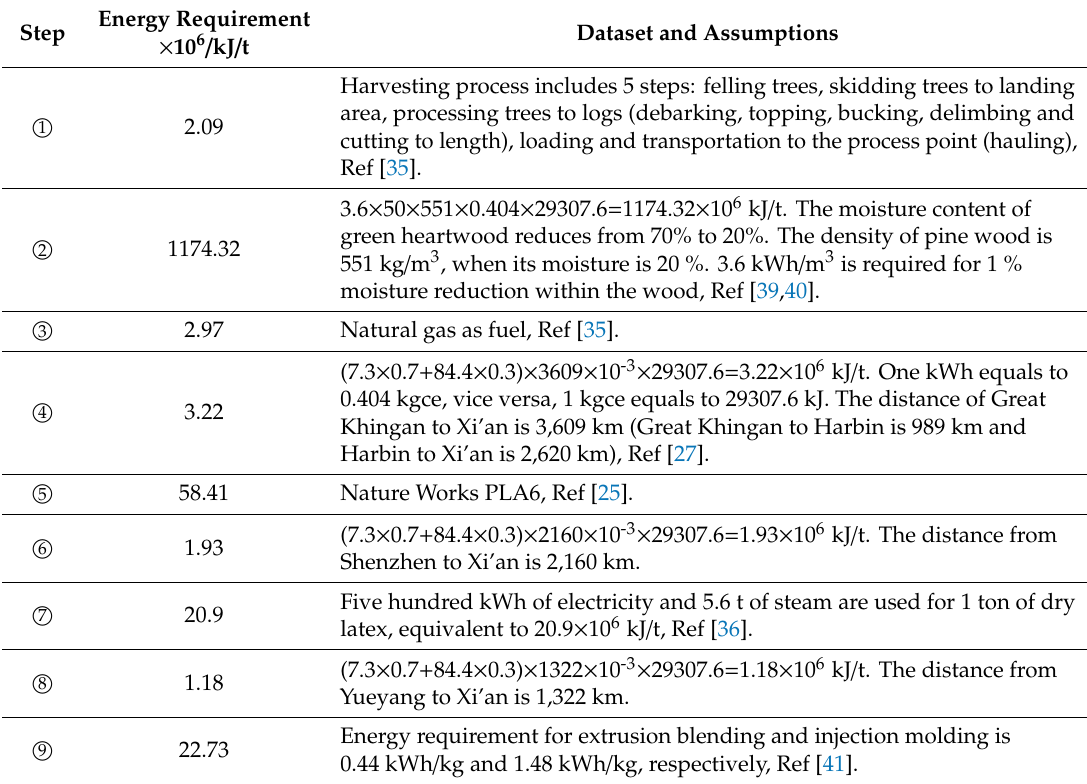
Table 4. Energy requirements for 1 ton of the PLA-based